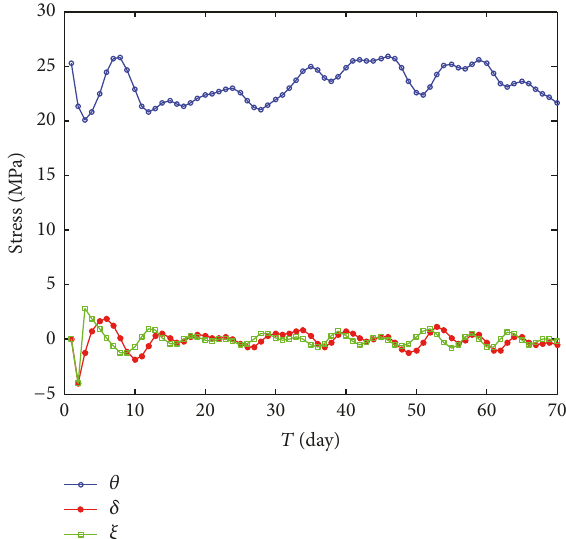
Figure 5: Monitored extreme stress data and resampled extreme stress data.